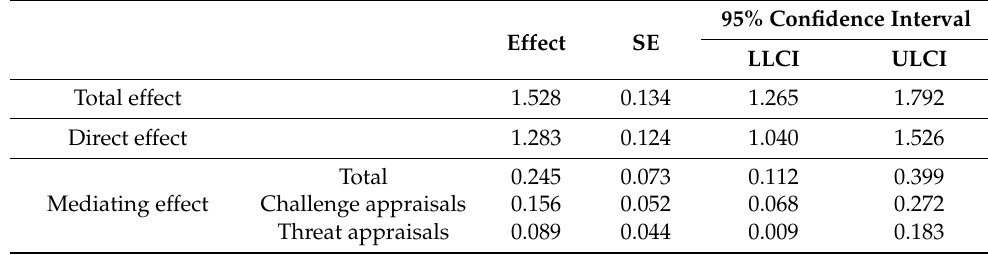
Table 7. Total effect, direct effect and mediating